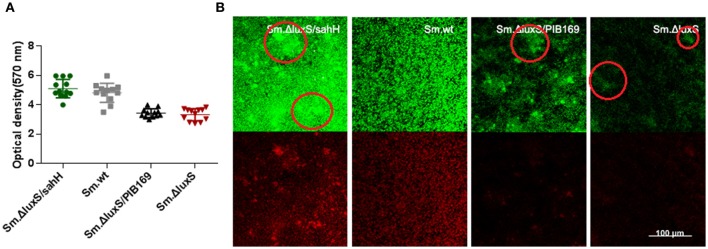
Quantification of biofilms by CV staining and CLSM of biofilms formed by S. mutans and derivative strains. (A) Quantification of biofilms. Two independent experiments were performed (n = 3 for each strain). The results are shown as mean ± SD, and the asterisks represent a significant difference (P < 0.05) compared to the Sm.ΔluxS strain. (B) The CLSM of biofilms. Double-labeling imaging of bacteria (green) and EPS (red) of biofilm formed on the surface of glass coverslips, showing the topographic features of biofilm. Images are representative of compressed biofilms in strains Sm.wt, Sm.ΔluxS, Sm.ΔluxS/sahH, Sm.ΔluxS/pIB169. The distinct bulges which were resulting from high-density cell aggregates in Sm.ΔluxS/sahH, Sm.ΔluxS, and Sm.ΔluxS/pIB169 were circled. Images were randomly captured from each sample.